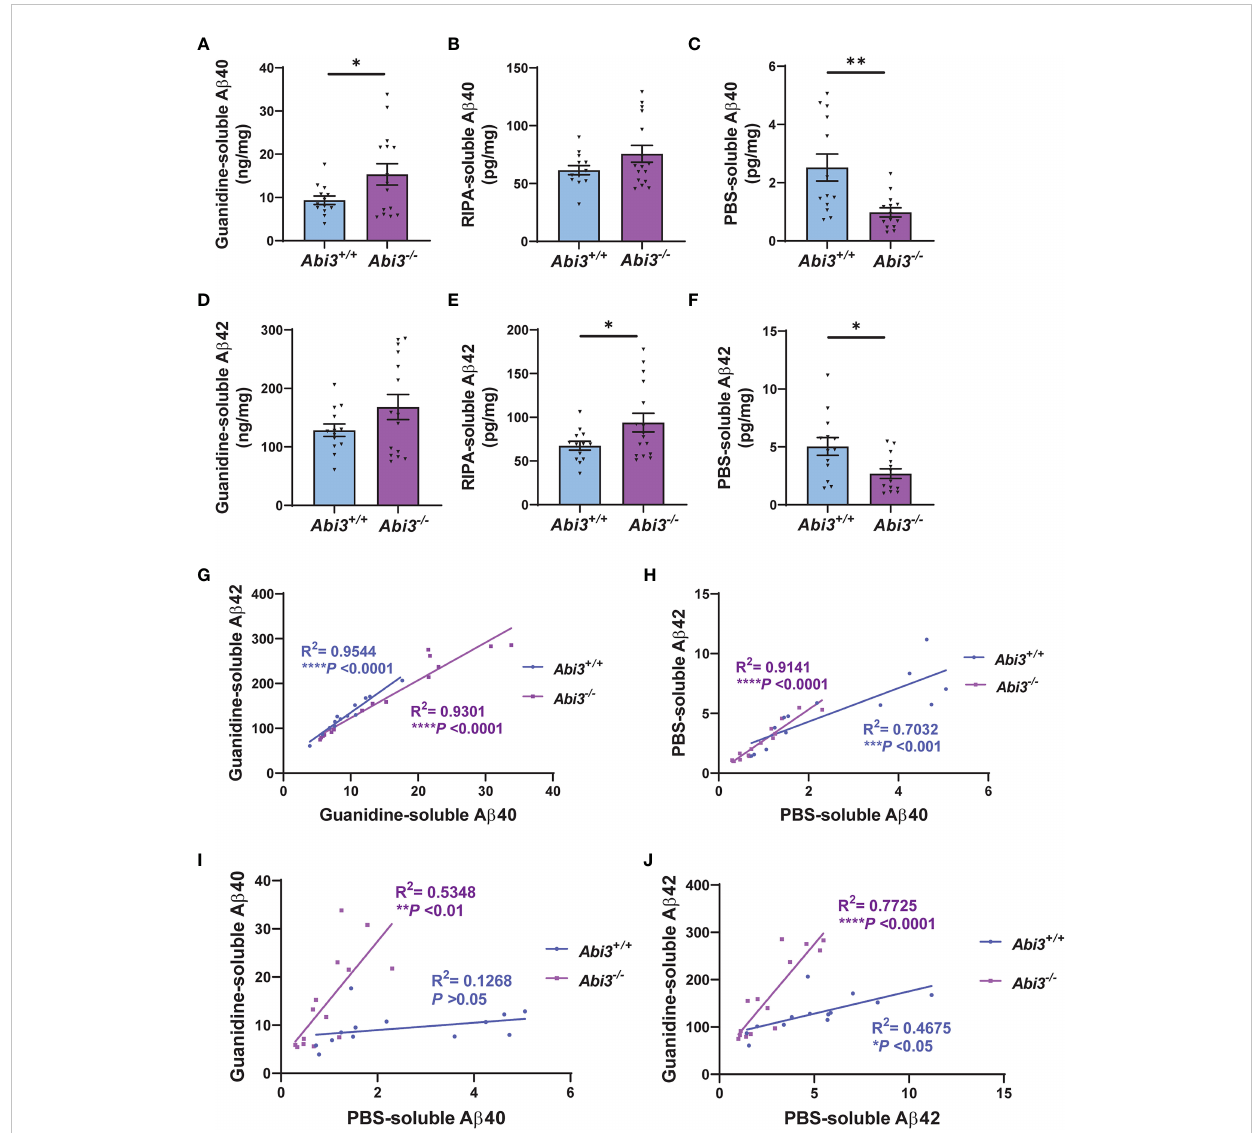
FIGURE 1 A b accumulation increases in Abi3 -/- mice. (A – C) Sequential protein extraction was performed on the cortical tissues with PBS, RIPA, and Guanidine buffer. The levels of A b 40 were measured in the (A) guanidine, (B) RIPA, and (C) PBS-soluble fractions of 5XFAD mouse cortices using an MSD electrochemiluminescence assay. (D – F) The levels of A b 42 were measured in the (D) guanidine, (E) RIPA, and (F) PBS-soluble fractions of 5XFAD mouse cortices (n=13-16). Data represent mean ± SEM. Unpaired two-tailed t-test; * p < 0.05, ** p < 0.01. (G, H) A signi fi cant correlation was observed between (G) Guanidine-soluble A b 40 and A b 42, and (H) PBS-soluble A b 40 and A b 42 levels. (I, J) Correlation analyses were performed between Guanidine-soluble and PBS-soluble fractions for (I) A b 40 and (J) A b 42 levels. Pearson ’ s correlation analysis; * p < 0.05, ***p < 0.001, ****p <